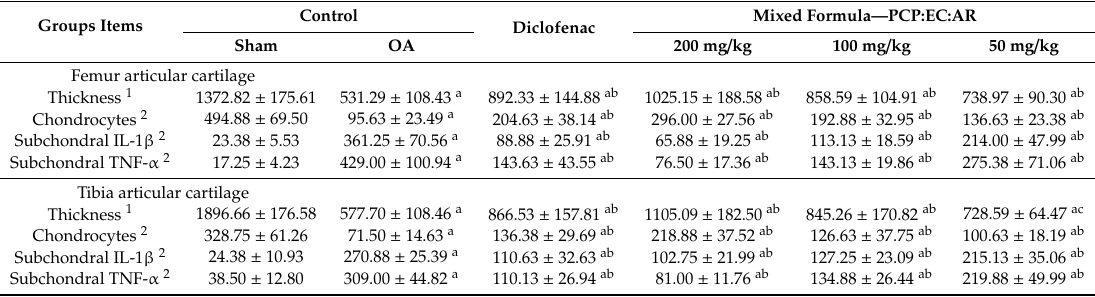
Table 6. Femur and tibia articular cartilage general histomorphometrical analysis in sham-operated or OA